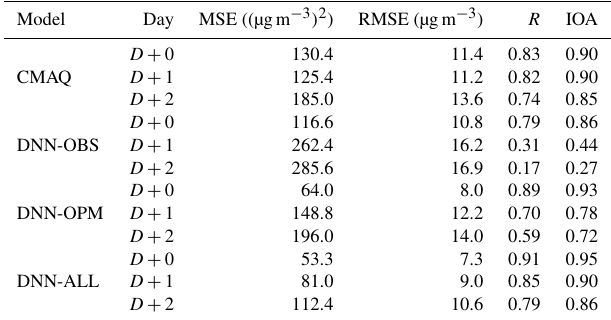
Table 5. Statistical summary of daily PM 2 . 5 concentration pre- diction performance of the CMAQ, DNN-OBS, DNN-OPM, and DNN-ALL